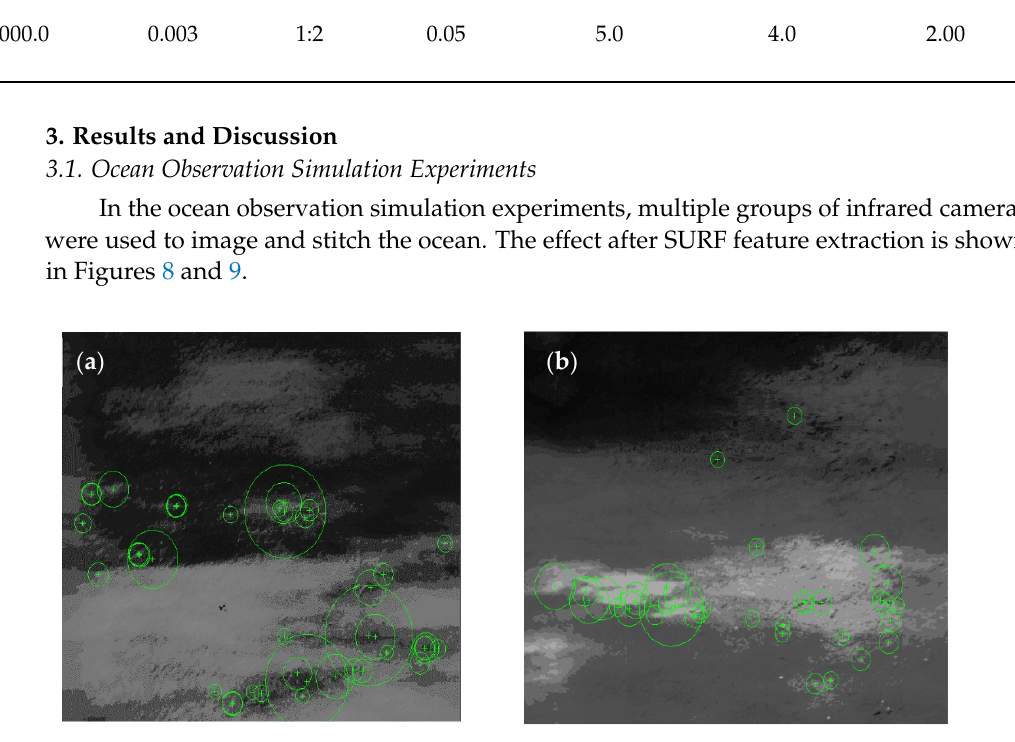
Figure 8. Extraction of feature points from infrared images of the ocean surface. ( a , b ) are the distributions of image feature points at different times.